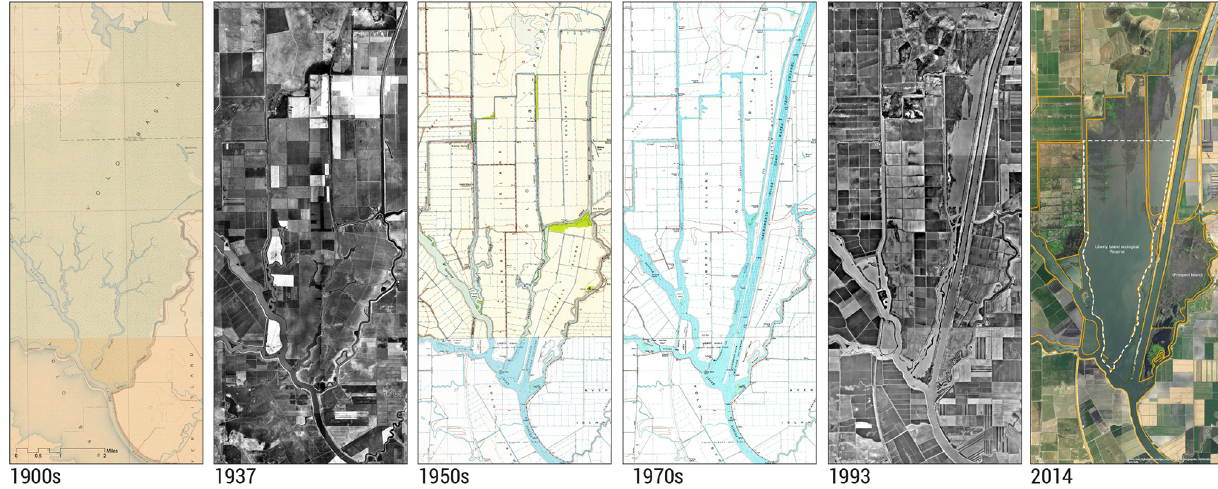
Figure 3. Evolution of the North Delta and Liberty Island: 1900–2014. The sequential series of maps show Liberty Island and the North Delta’s transformation from marshland and sloughs, to reclaimed agricultural fields, to the dredging of the Sacramento Deep Water Shipping channel, to re-naturalized landscape “reclaimed” as an ecological reserve. Historic survey data and 1937 ortho imagery from the San Francisco Estuary Institute. Image by Brett Milligan.